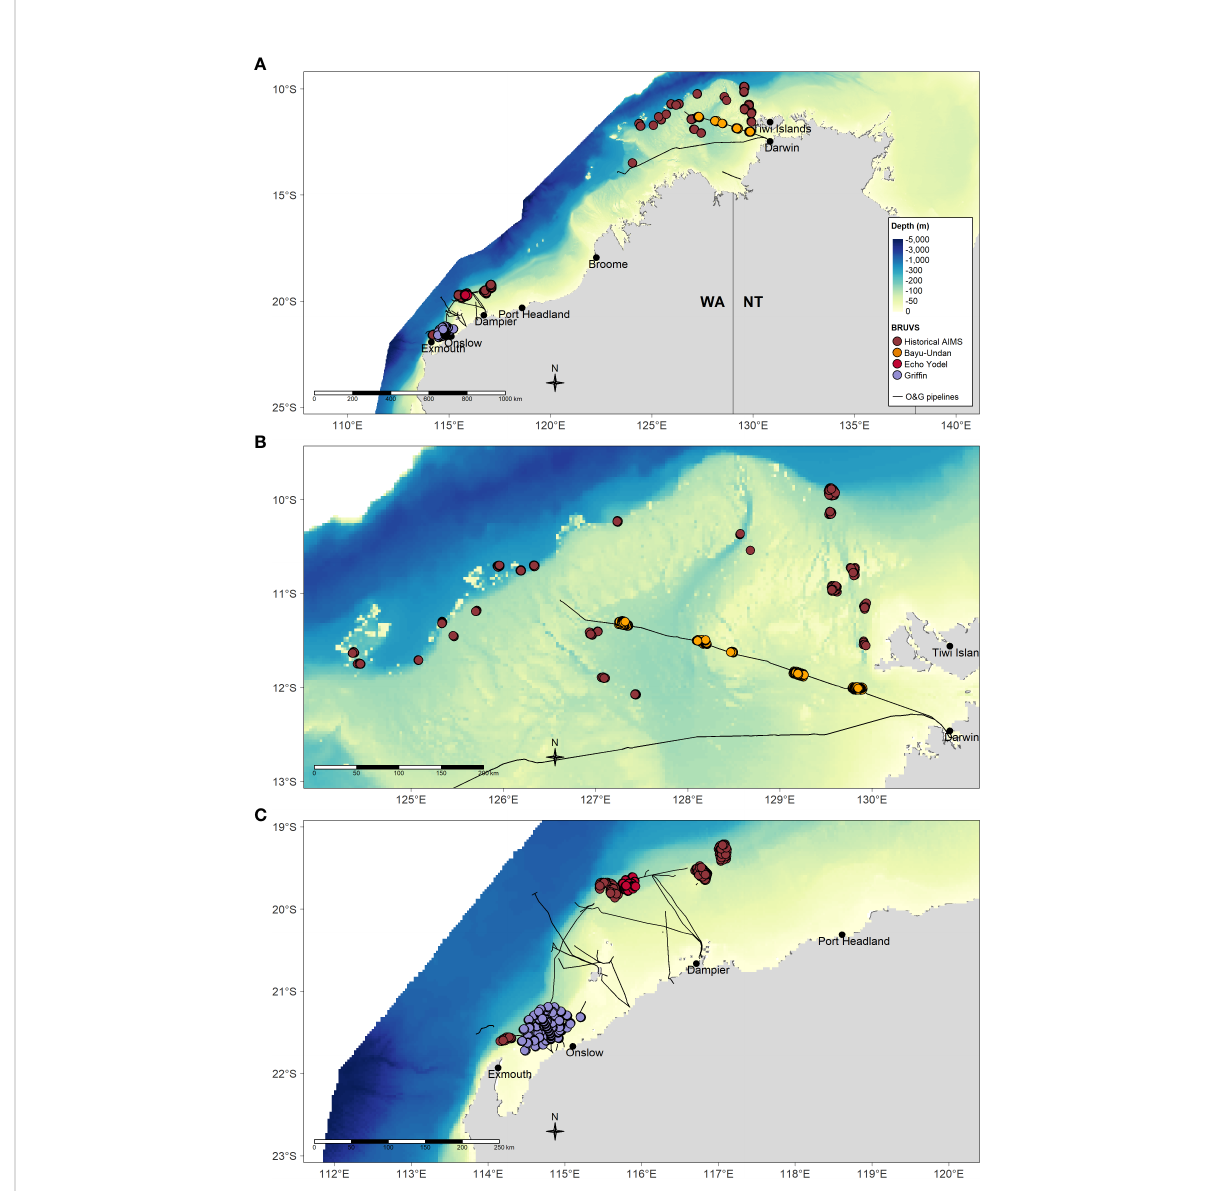
FIGURE 1 Location of individual BRUV deployments for which data were included in the present study from (A) across the region, (B) in the north and including the Bayu-Undan pipeline and, (C) in the north-west including Grif fi n and Echo Yodel pipelines and from historical AIMS BRUVs deployments in natural habitats. The studies for which the BRUVs data were collected are documented in Table 1. Depth raster sourced from Geoscience Australia 250 m bathymetry grid (Whiteway,